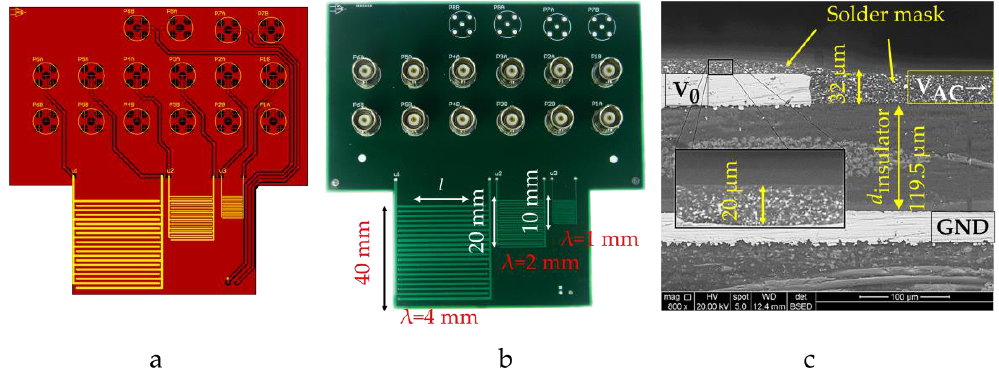
Figure 3. IDS used in this publication showing wavelengths and dimensions. ( a ) Multilayer PCB layout and ( b ) the manufactured version; ( c ) The SEM image shows the cross sectional structure of the manufactured IDS.